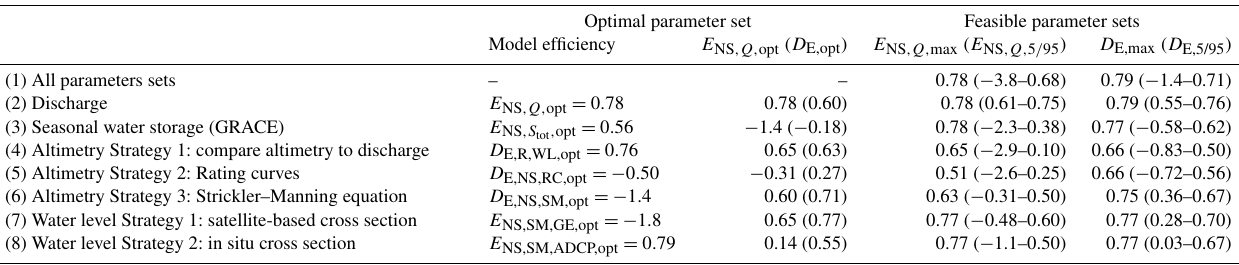
Table 7. Summary of the model results: elimination of unfeasible parameter sets and detection of optimal parameter set according to each parameter identification strategy including the corresponding model performance range ( E NS ,Q , D E ) indicating the model’s skill at repro- ducing the discharge during the benchmark time period. For each strategy, the model efficiency for the optimal parameter set is summarized together with the corresponding performance metrics with respect to discharge ( E NS ,Q, opt , D E,opt ). For all parameter sets retained as feasi- ble, the maximum ( E NS ,Q, max ,D E,max ) and 5 / 95th percentiles ( E NS ,Q, 5 / 95 , D E,5/95 ) of all performance metrics with respect to discharge are summarized. Data sources used for the parameter set selection: (1) all parameter sets (no data), (2) discharge, (3) GRACE, (4) altimetry combined with GRACE (Altimetry Strategy 1), (5) altimetry data using rating curves combined with GRACE (Altimetry Strategy 2), (6) al- timetry data using the Strickler–Manning equation combined with GRACE (Altimetry Strategy 3), and (7) daily river water level combined with GRACE using the Strickler–Manning equation and cross-section information retrieved from Google Earth (Water level Strategy 1) or (8) obtained from a detailed field survey with an ADCP (Water level Strategy